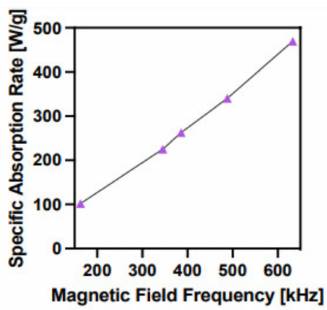
Figure 4. Dependence of SAR for SPION@Au nanoparticles on the magnetic field